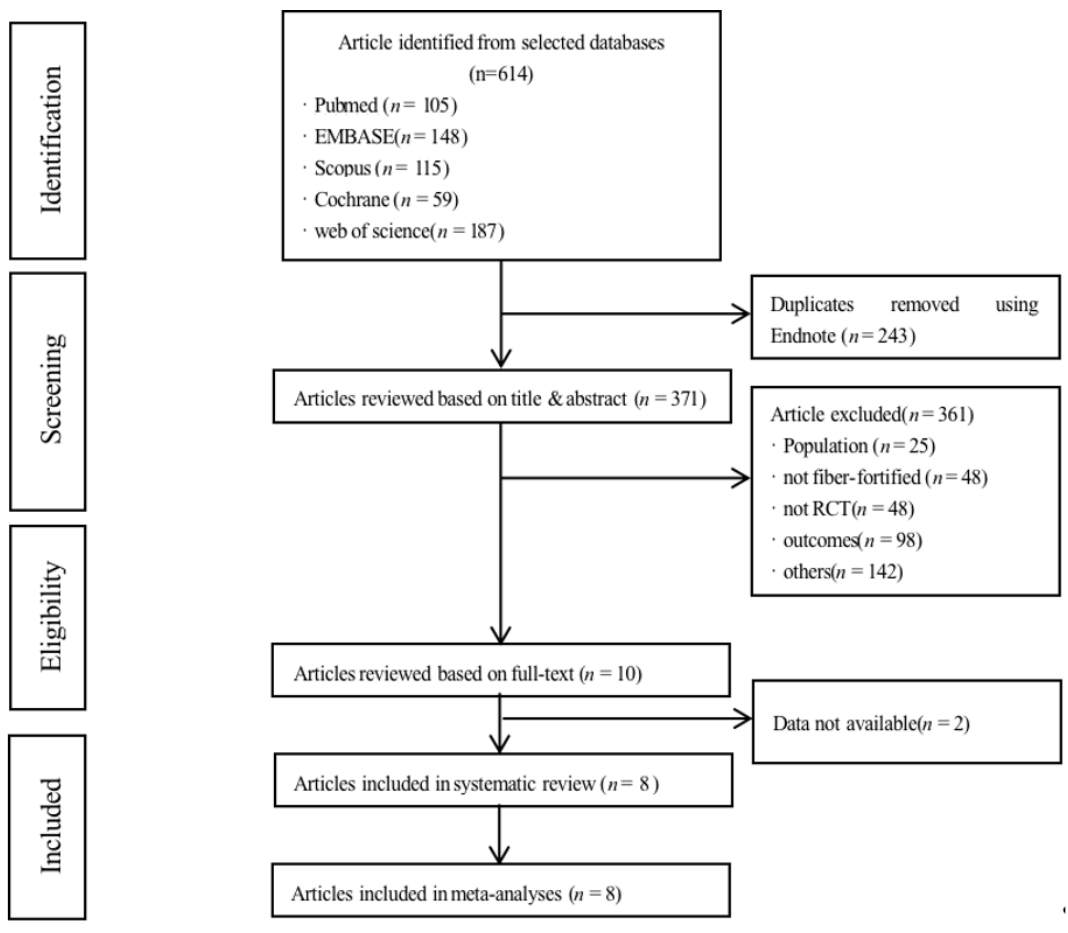
Figure 1. Flow chart from search to meta-analysis. Table 1 summarized the characteristics of the study, which included eight articles Table 1. Study characteristics of the eight included